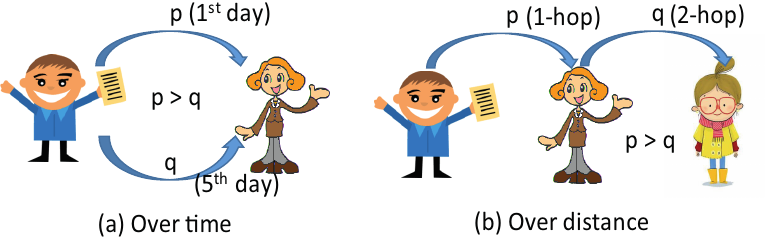
Figure 1. Examples of decaying diffusion rate of information. (Initial diffusion rate p and decayed rate q : ( a ) over time and ( b ) over